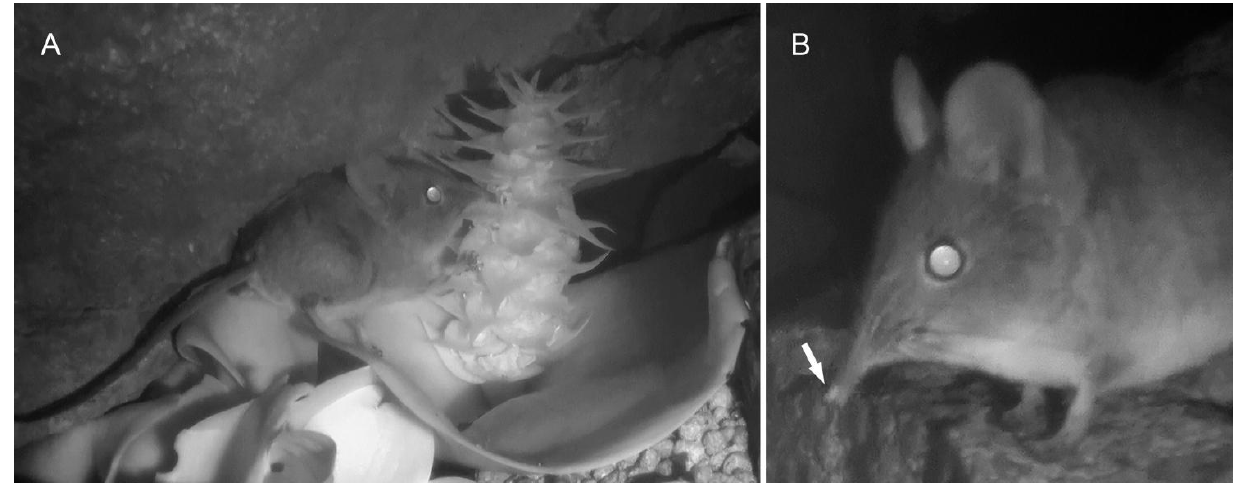
licks nectar from flowers of the Pagoda Lily (Whiteheadia bifolia, Asparagaceae) growing in rock crevices in the Namaqualand of South Africa. (B) The elephant-shrew has pollen (see arrow) on its nose after a flower visit. Both still images are from infrared video